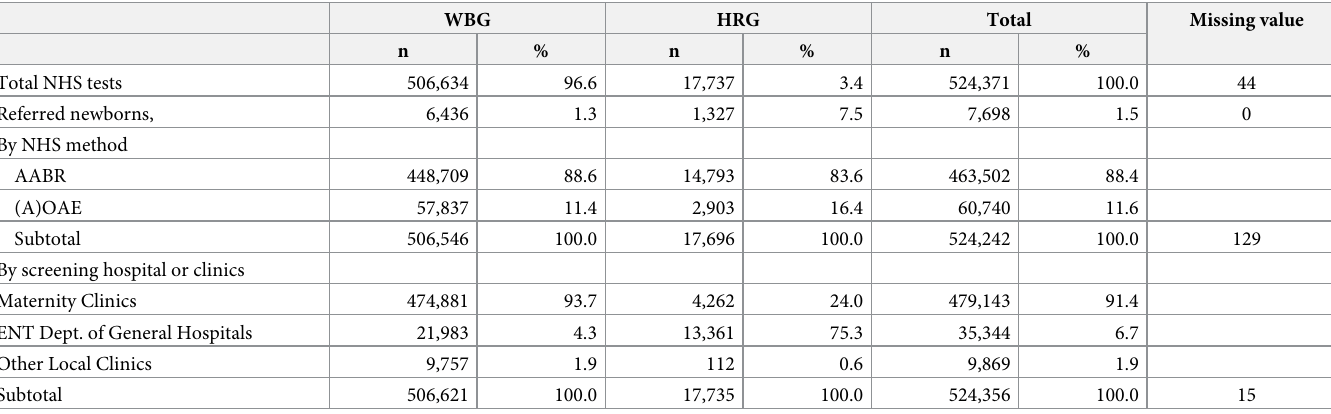
Table 1. Newborn hearing screening (NHS) state of well-baby group (WBG) and high-risk group (HRG) in NHS pilot program from 2010 to 2018 in Korea. WBG HRG Total Missing value n % n